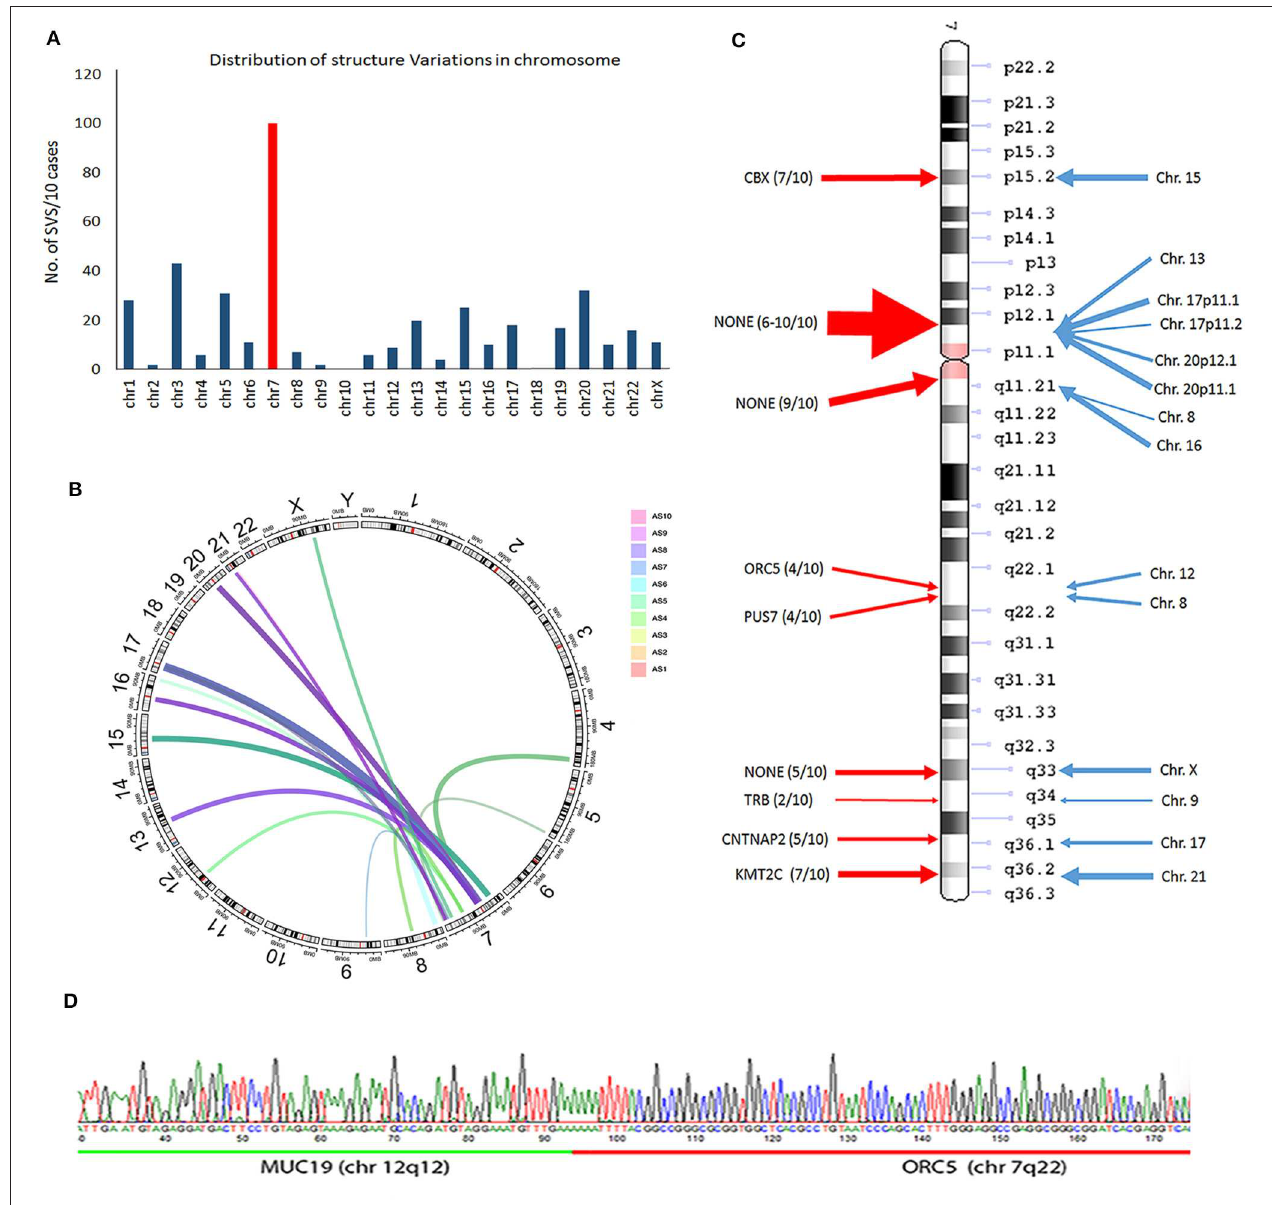
FIGURE 4 | Frequent structure variation (SV) changes in chromosome 7. (A) Histoplots show the number of SV changes in each chromosome (chr 7 is in red). (B) Circos plot illustrates the inframe gene and genomic rearrangement between chr 7 and other chr partners (assembled from 10 cases; line thickness indicates the relative frequency of SV). (C) SV distribution and number of SV changes (thickness of arrows) in chr 7 (red arrows) region and other chr partners (blue arrows). The candidate genes in each SV region are listed. (D) An example of SV changes validated by PCR and Sanger sequencing analysis through two different gene fusion regions (upstream gene in green; downstream gene in